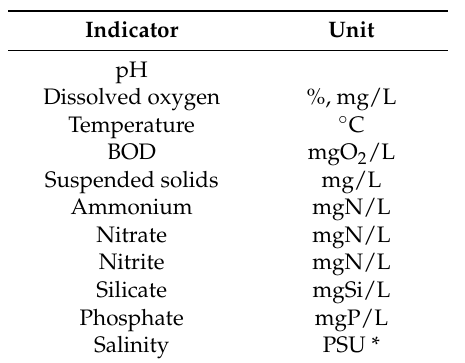
Table 3. Measured physical-chemical